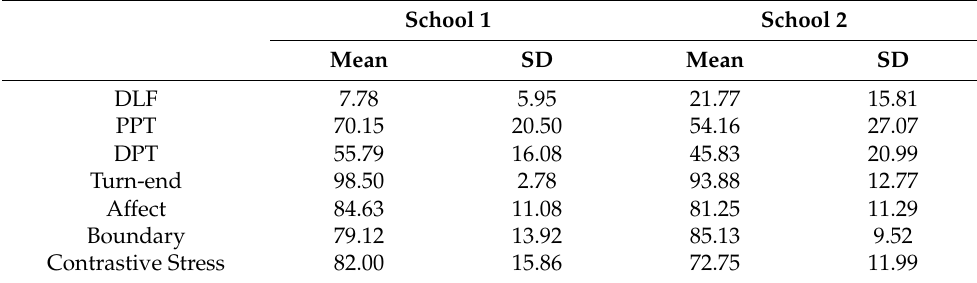
Table 2. Means and standard deviations per group for each experimental